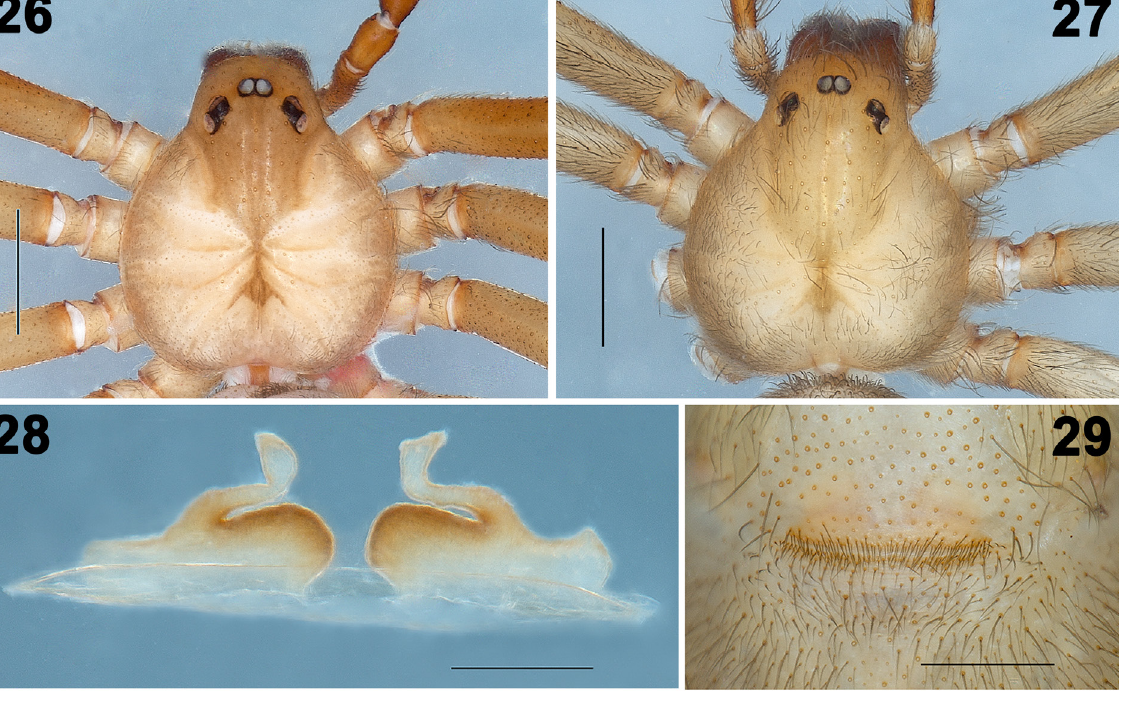
Figs 26–29. Loxosceles tolantongo sp. nov. 26–27 . Caparace of ♂ holotype (CNAN-T01317) and ♀ paratype (CNAN-T01321), respectively. 28 – 29 . ♀ paratype (CNAN-T01321). 28 . Seminal receptacles. 29 . Genital area, ventral view. Scale bars: 26–27 = 1 mm; 28 = 0.2 mm; 29 = 0.5